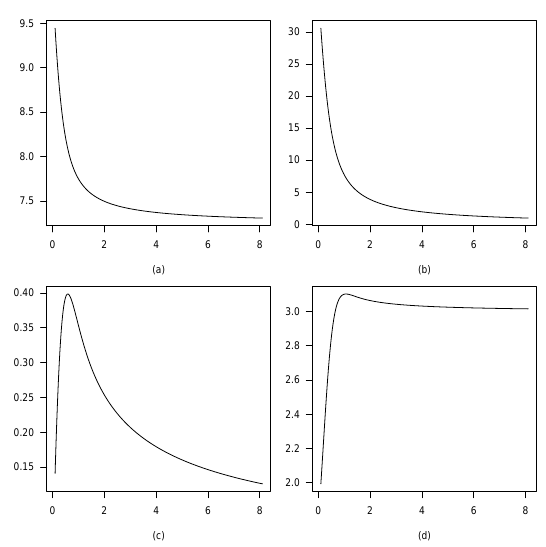
Figure 13 – Mean, in panel (a), variance, in panel (b), skewness, in panel (c), kurtosis, in panel (d), of the intermediate Poisson distributions { q